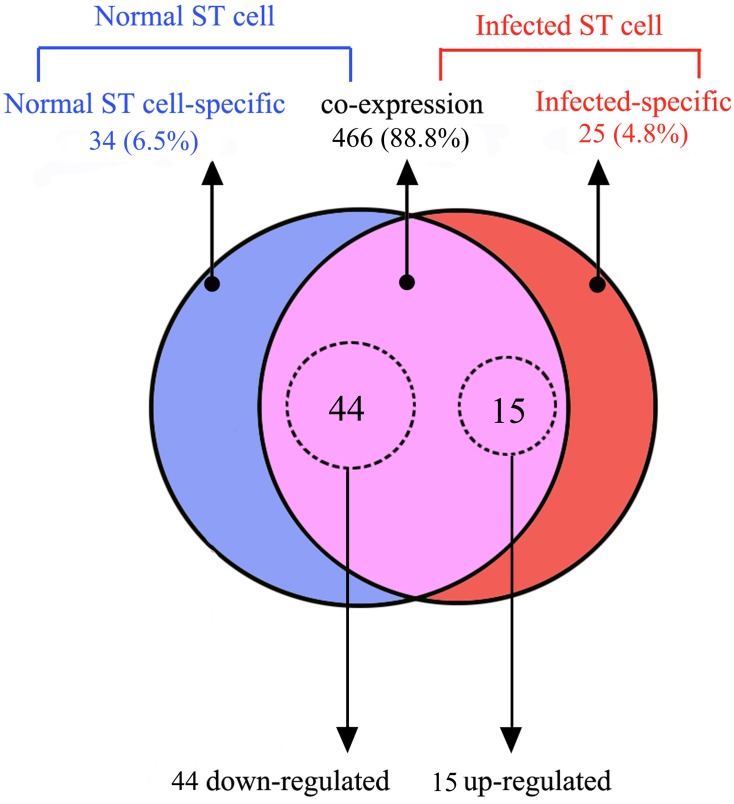
Comparison of differentially expressed miRNAs between the normal ST cell and TGEV-infected ST cell samples (p<0.0001).The Venn diagram shows the distribution of 525 unique miRNAs between normal ST cell (left, blue circle) and TGEV-infected ST cell sample (right, red circle) libraries. The overlapping section represents 466 co-expressed miRNAs. The dashed circles indicated the miRNAs that were significantly differentially expressed (p<0.0001).